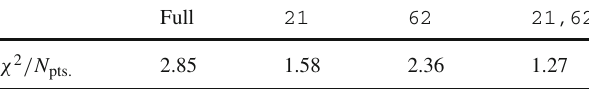
Table 1 χ 2 per number of data points ( N pts = 140) for fit to